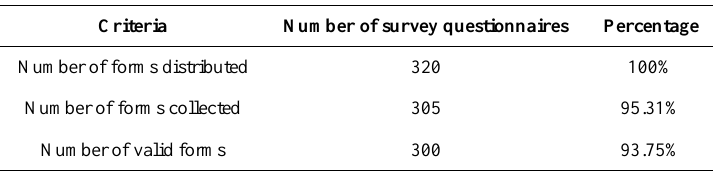
Table 1. Customer survey results